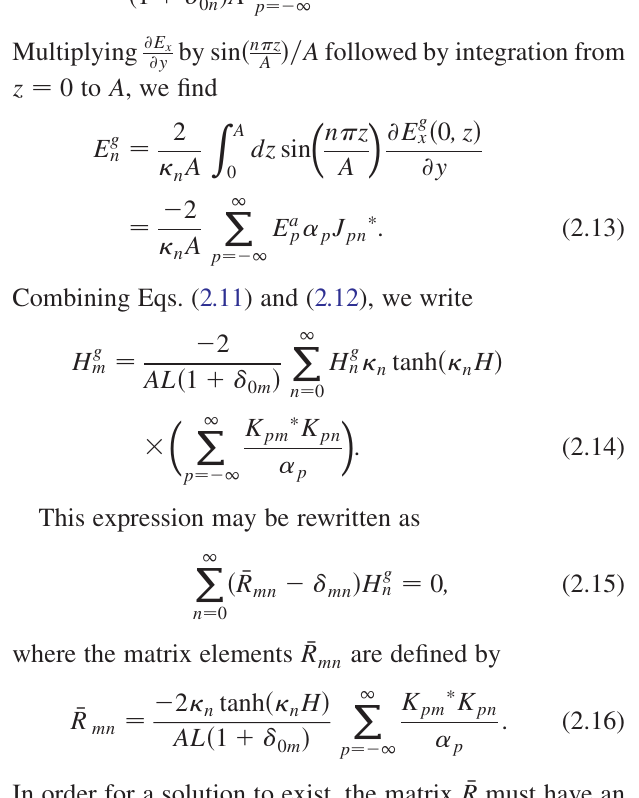
FIG. 1. Sketch of the 3D MAGIC simulation geometry, showing the grating in its surroundings, along with a transverse section indicating the grating parameters and the height of the simula- tion volume. The walls are composed of ‘‘free space,’’ which absorbs radiation emerging from the